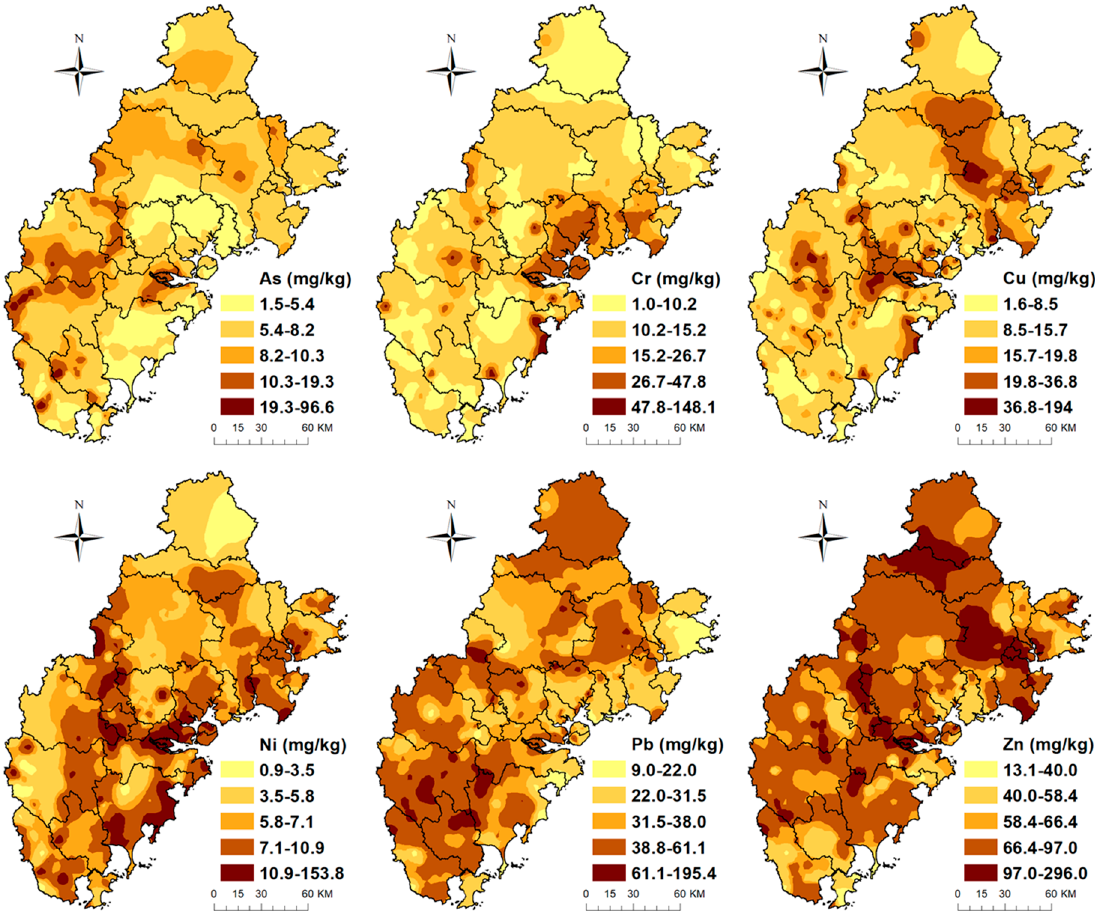
Figure 3. Spatial distribution maps of the concentrations of six trace metals in the soils of the Golden Triangle.